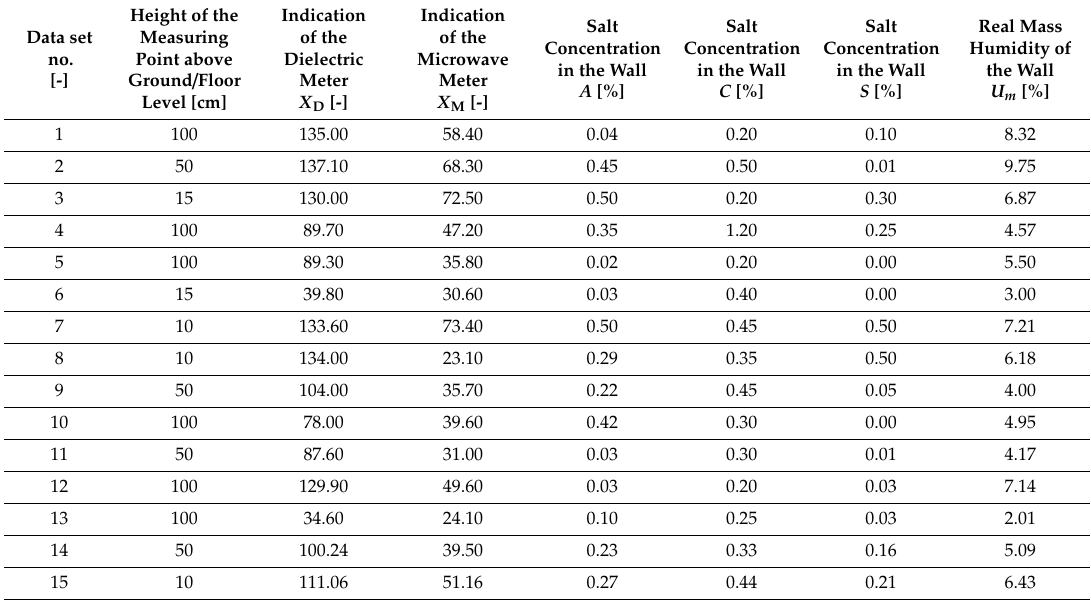
Table 2. Test results of sets prepared for experimental verification of the artificial neural network. Data set no.